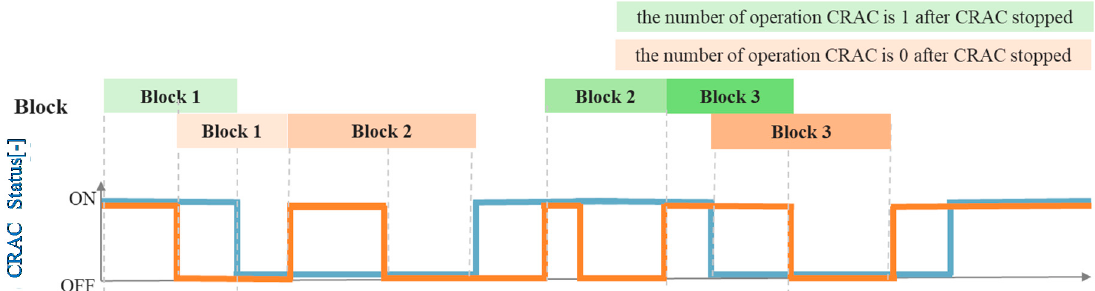
Figure 13. Image of blocks (case where only one CRAC is operating).